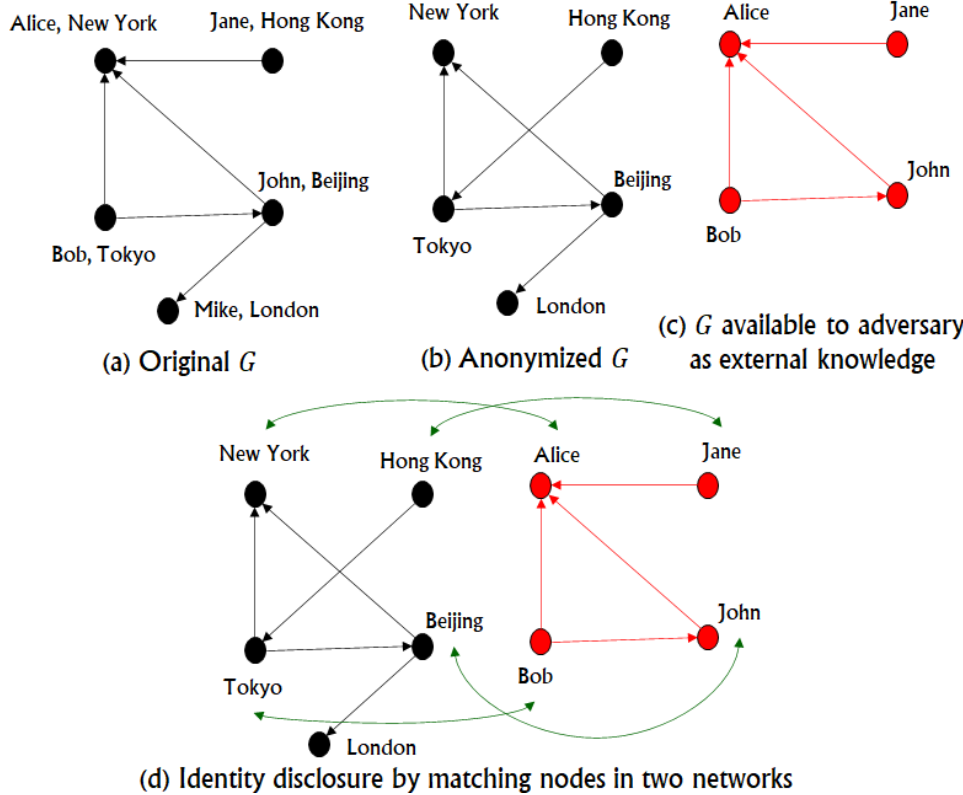
Figure 24. Overview of G de-anonymization using auxiliary graph (adopted from [258]). Table 9. SOTA de-anonymization approaches proposed for breaching users’ privacy in OSNs.